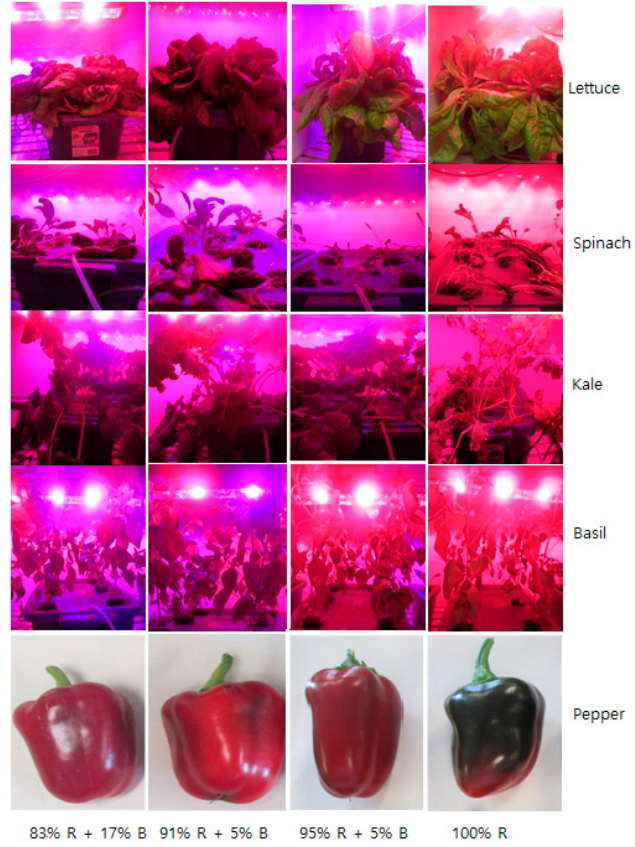
Figure 1. Morphological features of different plant species grown under various ratios of R and B light